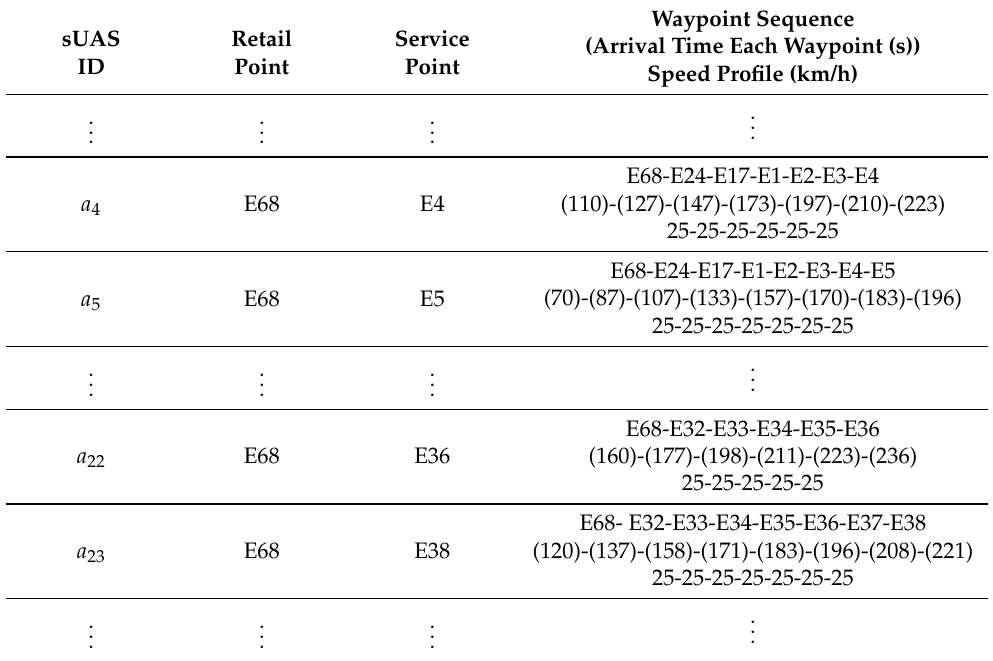
Table 2. Flight planning results of 30 sUASs for the 1-to- M case (outer loop: LCFS